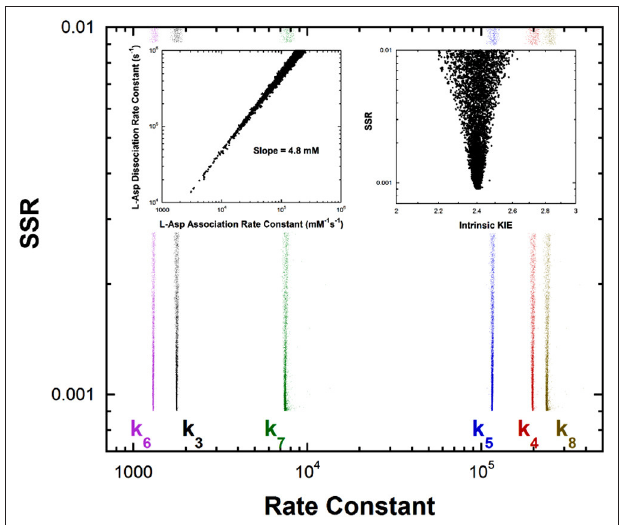
FIGURE 4 | Results of global optimization for the L-asp/oxalacetate half-reaction of aspartate aminotransferase. SSR, sum of squared residuals of the fit to the target function. The figure was generated from ∼ 40,000 independent runs, each starting from randomized sets of rate constants. The insets show that the correlation between the association and dissociation rate constants for L-Asp binding. The individual rate constants are not well-determined, but their ratio is over a broad range of values, indicating rapid equilibrium binding. The observed ratio of the rate constants is 4.8mM, which is the K M value for L-Asp. The intrinsic KIE calculated in the global optimization is also presented as an inset.